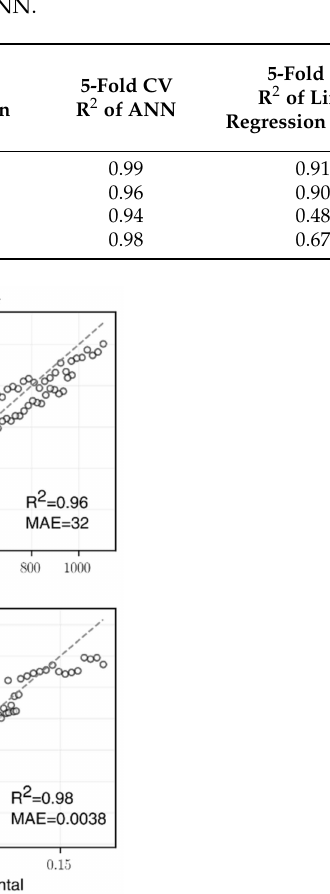
Figure 32. The parity plots for all four ANN models. After the models were developed, the sensitivity analysis was performed on both the linear regression baseline and the ANNs. For linear regressions, the gradients were simply the weights, and for ANNs, the gradients were obtained from backpropagation. Figure 33 shows the averaged gradients from the individual folds of cross-validation. In general, the gradients from both the LR and ANN models have the same trend except for n relax , where the paraffin oil content has a positive gradient in LR but negative gradient in ANN.